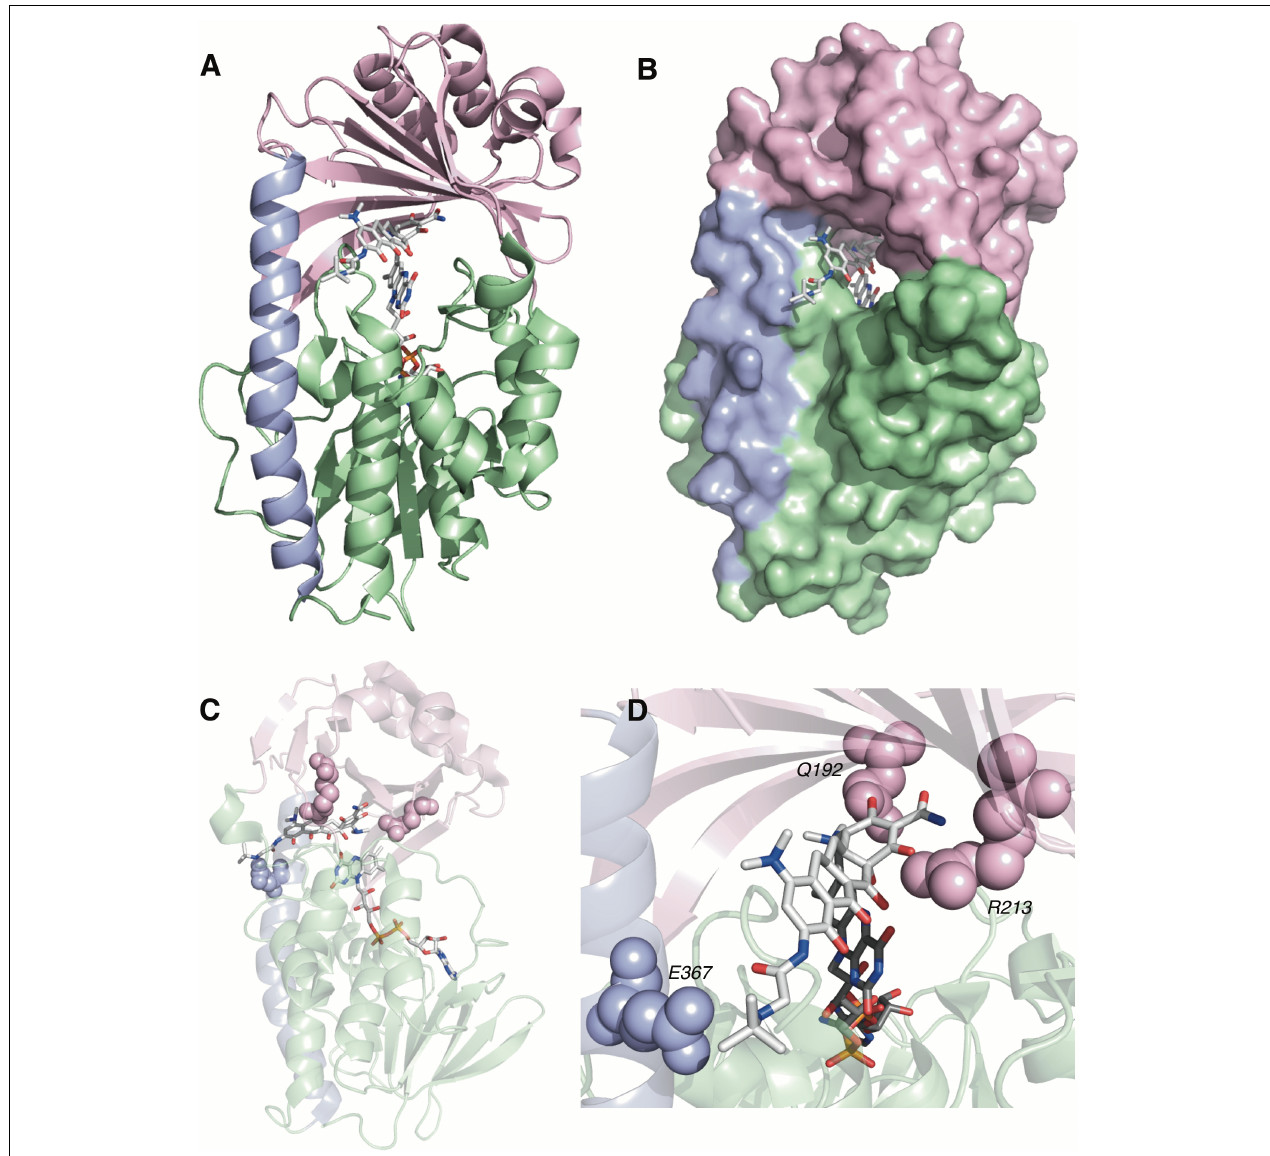
FIGURE 14 | (A) X-ray structure of tigecycline bound to TetX in Mode I D , A (PDB accession number 4a6n). (B) Surface view of X-ray structure of tigecycline bound to TetX in Mode I D , A . (C) X-ray structure of tigecycline bound to TetX in Mode I D , A with relevant substrate recognition interactions highlighted. (D) Expanded X-ray structure of tigecycline bound to TetX in Mode I D , A with relevant substrate recognition interactions highlighted for the A-ring (Q192, R213) and the D -ring N - t -butyl-glycylamide substituent (E367). Electron density for the C2-carboxamide bond was missing in the PDB file 4a6n. The C2-carboxamide bond was added using the create bond function in PyMOL. Images were generated using PyMOL